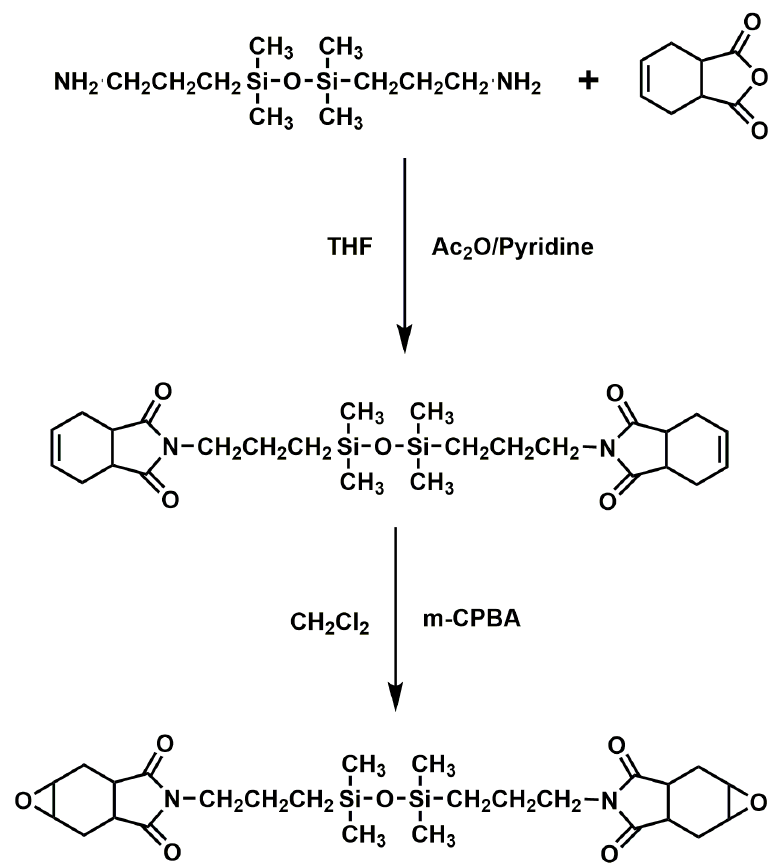
Figure 14. Synthesis of imide ring and siloxane-containing cycloaliphatic epoxy compound BISE. Readapted with permission from Ref. [142], Copyright 2007, Elsevier Ltd.